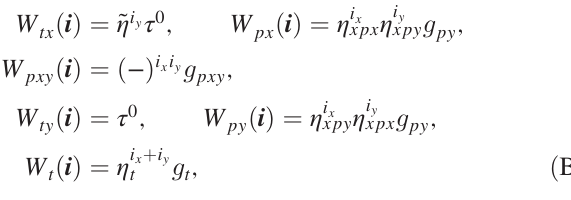
TABLE I. Symmetry fractionalization of U(1) spin